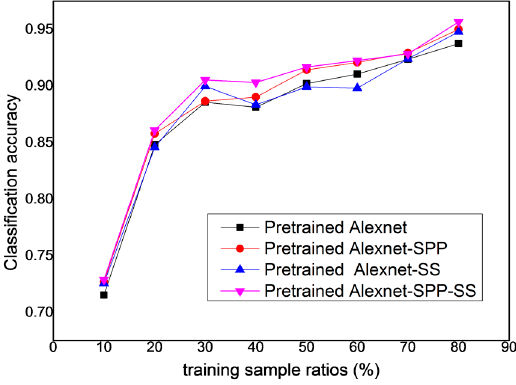
Figure 18. The influence of the training sample ratios with the different algorithms for the Google image dataset of SIRI-WHU.